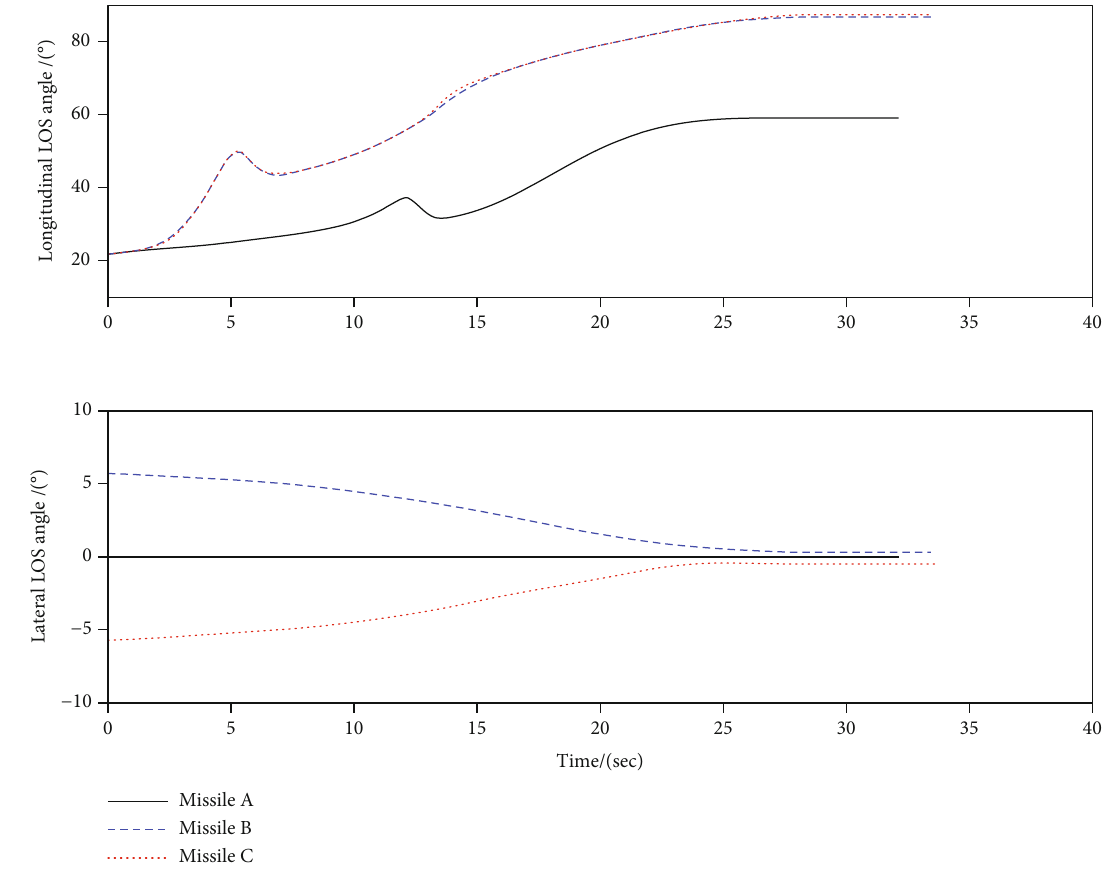
Figure 7: LOS angle curves in the longitudinal plane and lateral plane of three